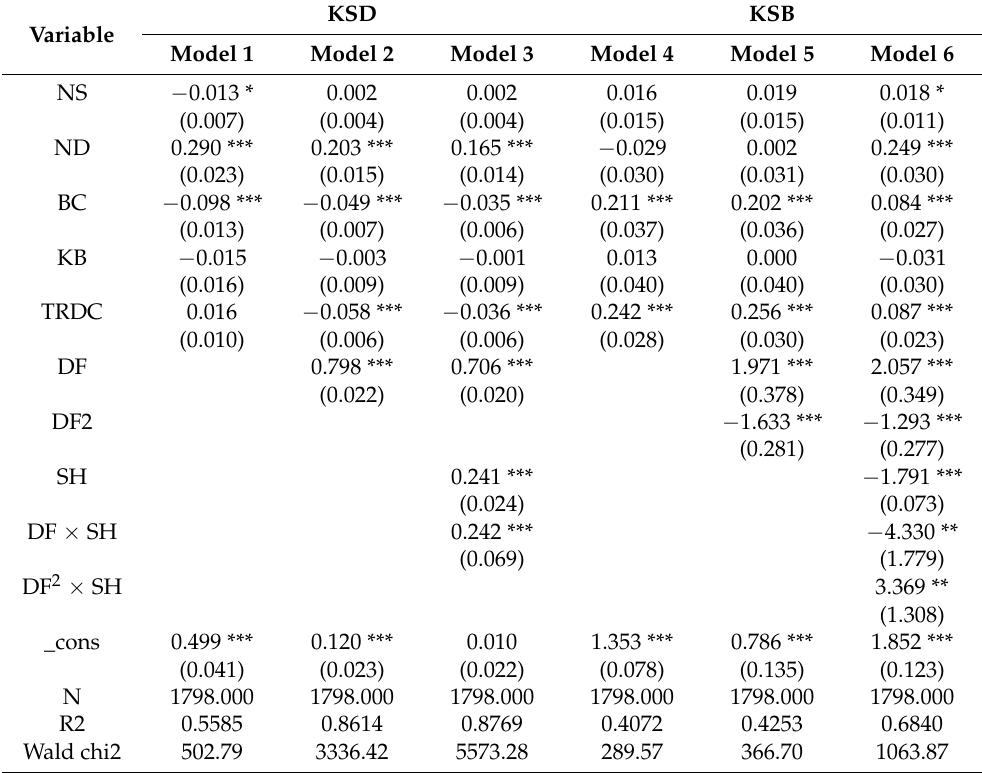
Table 3. Regression